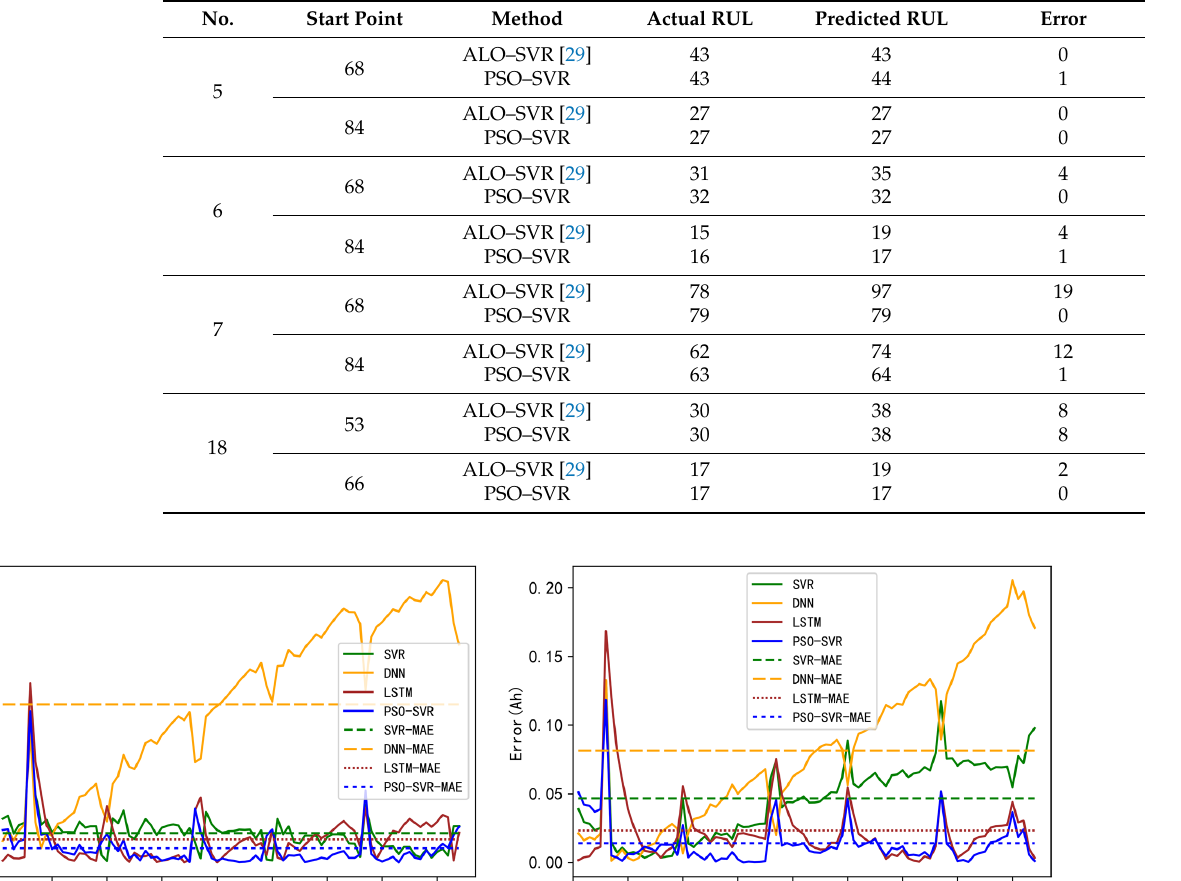
Table 5. Comparison of the results of PSO–SVR to that of other prediction methods.